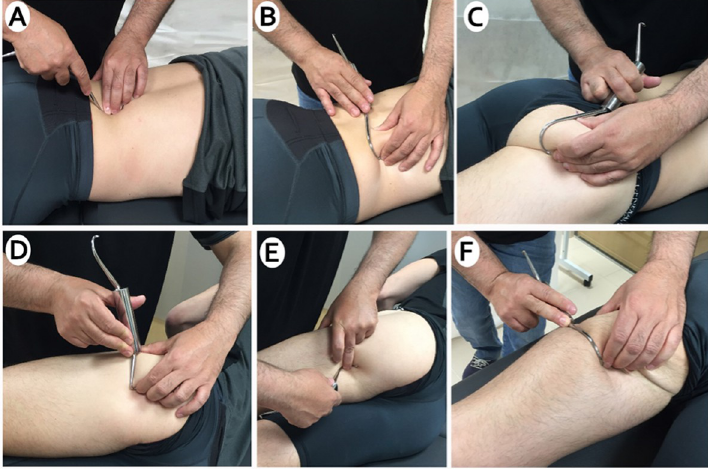
Table 1. Characteristics of participants.